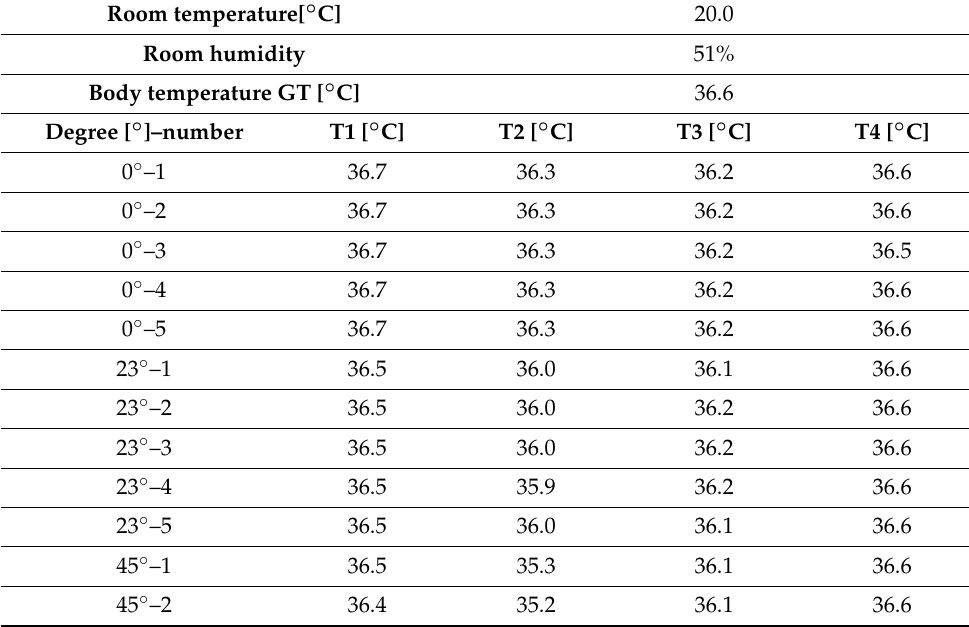
Table A9. Body–device angle experiment. Subject 3 body temperature